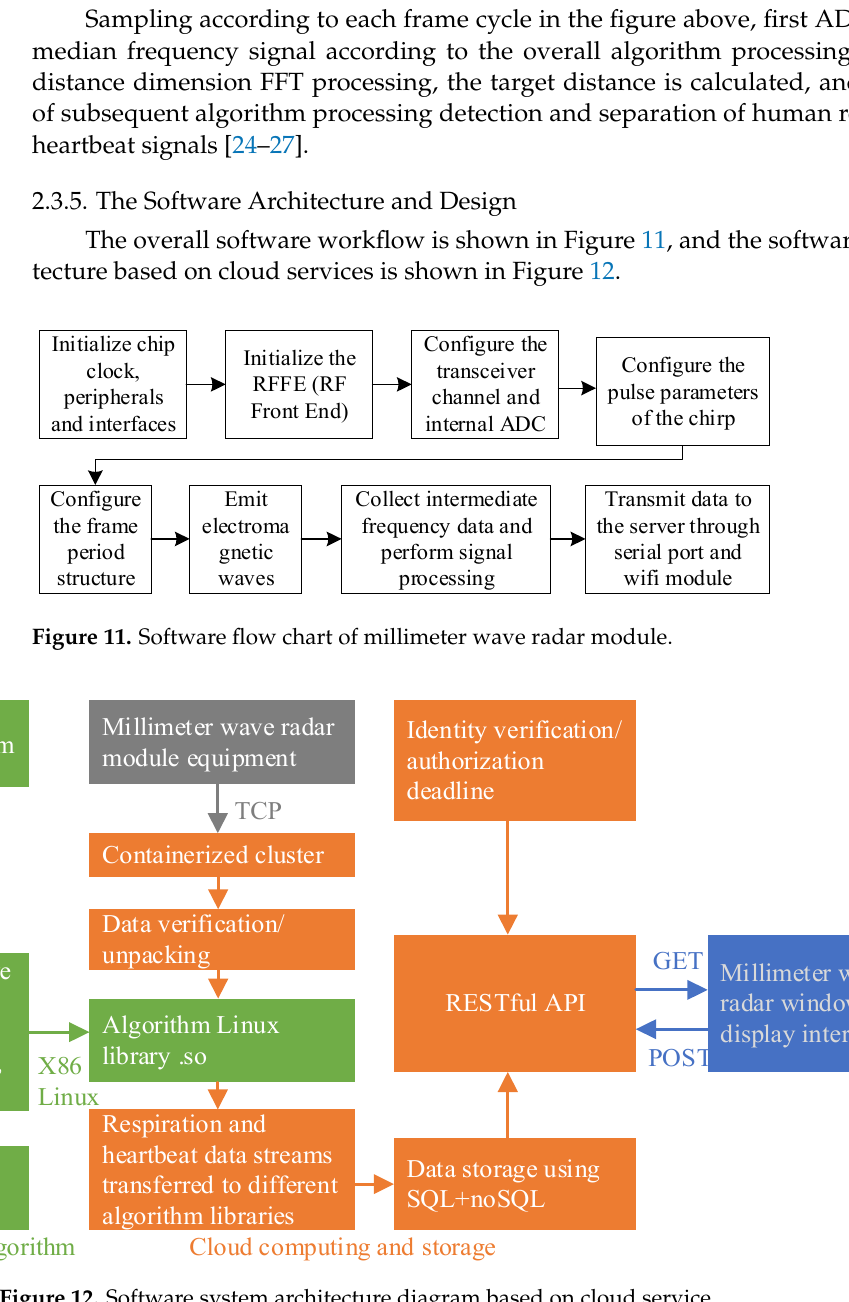
Figure 10. Emission waveform diagram [9–11]. Sampling according to each frame cycle in the figure above, first ADC samples the median frequency signal according to the overall algorithm processing process, then distance dimension FFT processing, the target distance is calculated, and then a series of subsequent algorithm processing detection and separation of human respiratory and heartbeat signals [24–27].